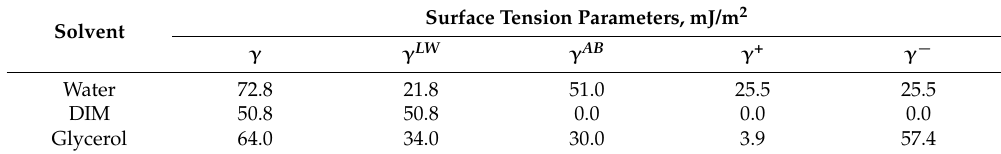
Table 1. Surface tension parameters for water, diiodomethane (DIM), and glycerol used in experiments.